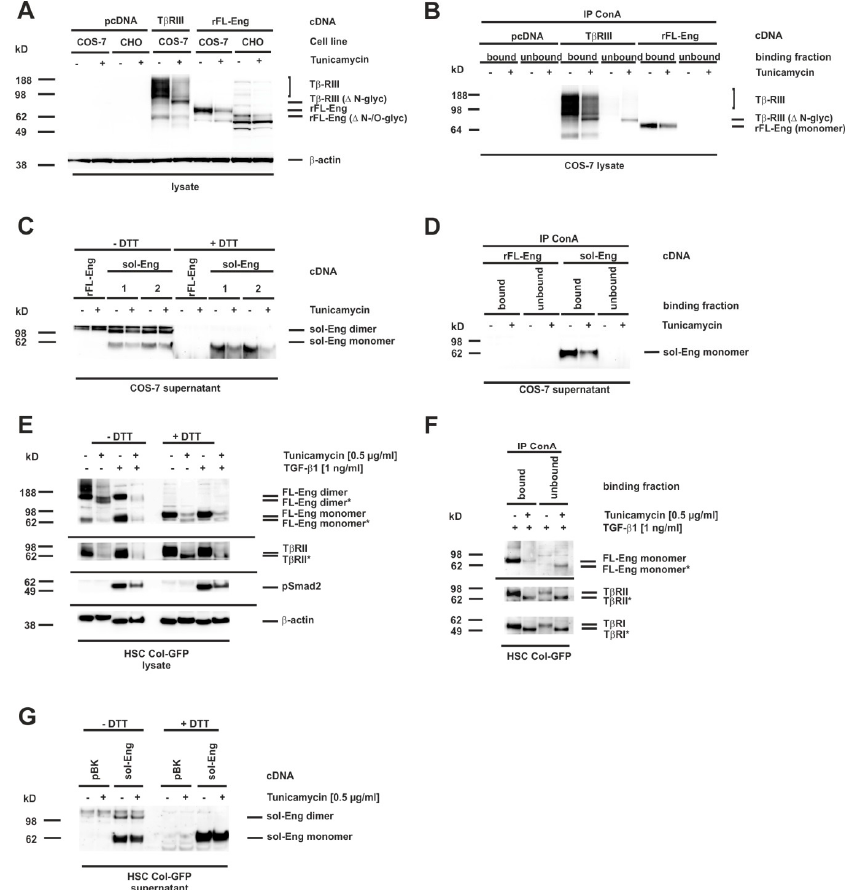
Figure 7. Blocking of N -glycosylation by tunicamycin leads to aberrant tra ffi cking of Endoglin. ( A – D ) CHO or COS-7 cells were transfected with plasmids directing expression of rat FL-Endoglin (rFL-Eng), betaglycan (T β RIII), and rat soluble Endoglin (sol-Eng). A transfection with empty vector (pcDNA) served as control. Thereafter, cells were treated with tunicamycin (0.5 µ g / mL, 24 h) or left untreated. ( A ) Cell extracts were prepared and analysed for expression of rFL-Eng and betaglycan. To monitor equal protein loading the membrane was reprobed with a β -actin specific antibody. ( B ) Cell lysates of COS-7 cells taken from ( A ) were incubated with ConA beads for precipation of glycosylated proteins. The ConA-bound fraction as well as the unbound fraction of the precipitates were then analysed by Western blot for rFL-Eng and betaglycan. ( C ) Supernatants of COS-7 cells transfected with vectors expressing rFL-Eng or sol-Eng were treated or not with tunicamycin (0.5 µ g / mL, 24 h). Protein extracts were analysed by Western blot in the presence or absence of DTT (50 mM) for expression of sol-Eng. ( D ) Supernatants of COS-7 cells taken from ( C ) were incubated with ConA beads for precipitation of glycosylated proteins. The ConA-bound fraction as well as the unbound fraction of the precipitates were then analysed by Western blot for sol-Eng. ( E ) HSC Col-GFP cells were treated or not with tunicamycin (0.5 µ g / mL, 24 h) and stimulated or not with TGF- β 1 (1 ng / mL; 30 min). Thereafter, proteins were extracted and analysed by Western blot in the presence or absence of DTT (50 mM) for expression or activation of indicated proteins. Equal protein loading was demonstrated with a β -actin specific antibody. ( F ) Protein lysates of HSC Col-GFP (only TGF- β 1 stimulated samples) taken from ( E ) were incubated with ConA beads for precipitation of glycosylated proteins. The ConA-bound fraction as well as the unbound fraction of the precipitates were then analysed by Western blot for the indicated receptor proteins. ( G ) HSC Col-GFP cells were transfected with a plasmid directing expression of rat soluble-Endoglin (sol-Eng) or empty vector control (pBK). Thereafter, cells were treated with tunicamycin (0.5 µ g / mL, 24 h) or left untreated. Cell protein extracts were prepared and analysed in Western blot in the presence or absence of DTT (50 mM) for expression of